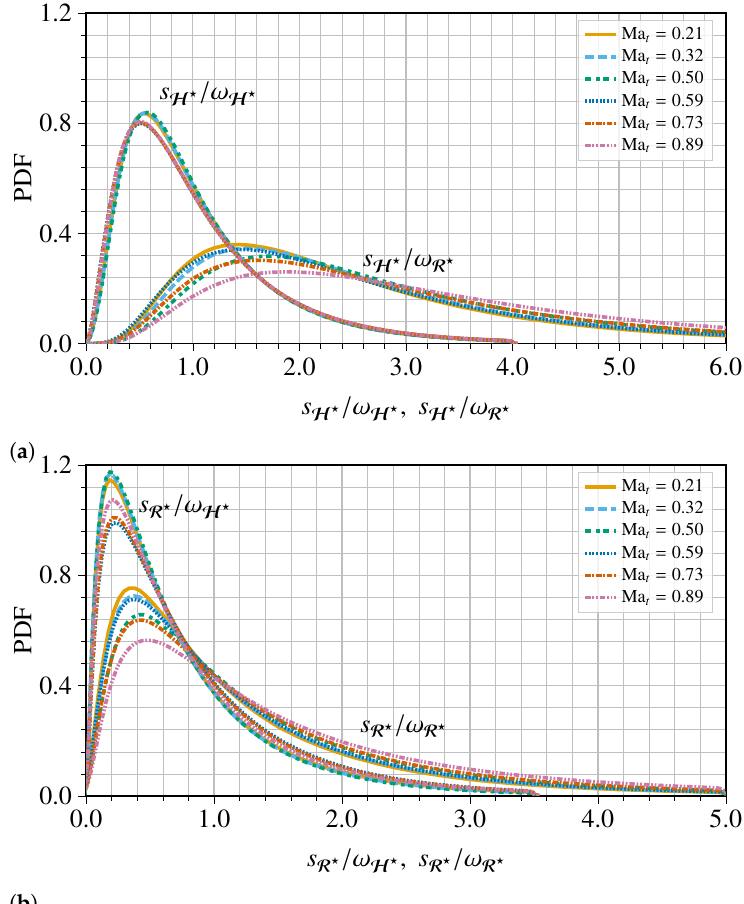
Figure 10. PDF of ( a ) s H (cid:63) / ω H (cid:63) , s H (cid:63) / ω R (cid:63) , and ( b ) s R (cid:63) / ω H (cid:63) , s R (cid:63) / ω R (cid:63) for six different Ma t .